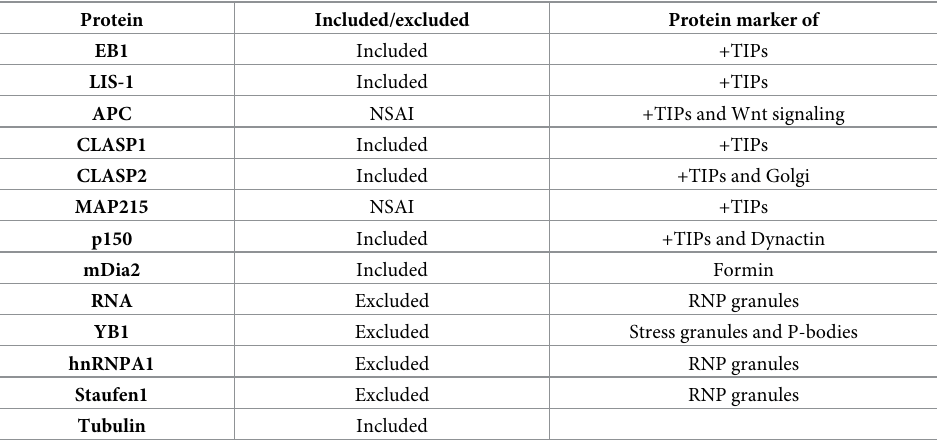
Table 1. List of molecules we have tested for co-localization with CLIP-170 patches.